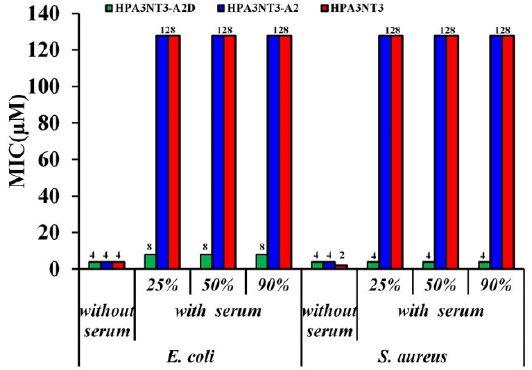
Figure 5. Antimicrobial activity of peptides against E. coli and S. aureus in the absence or presence of serum without anticoagulants. Peptides were mixed with various concentrations of serum (25%, 50%, and 90%) and incubated for 2 h at 37 °C, followed by the addition of bacterial cell suspensions to the mixtures. Afterward, aliquots of each sample were spread onto agar plates. The MIC was determined as the condition under which no viable colony formation was observed.